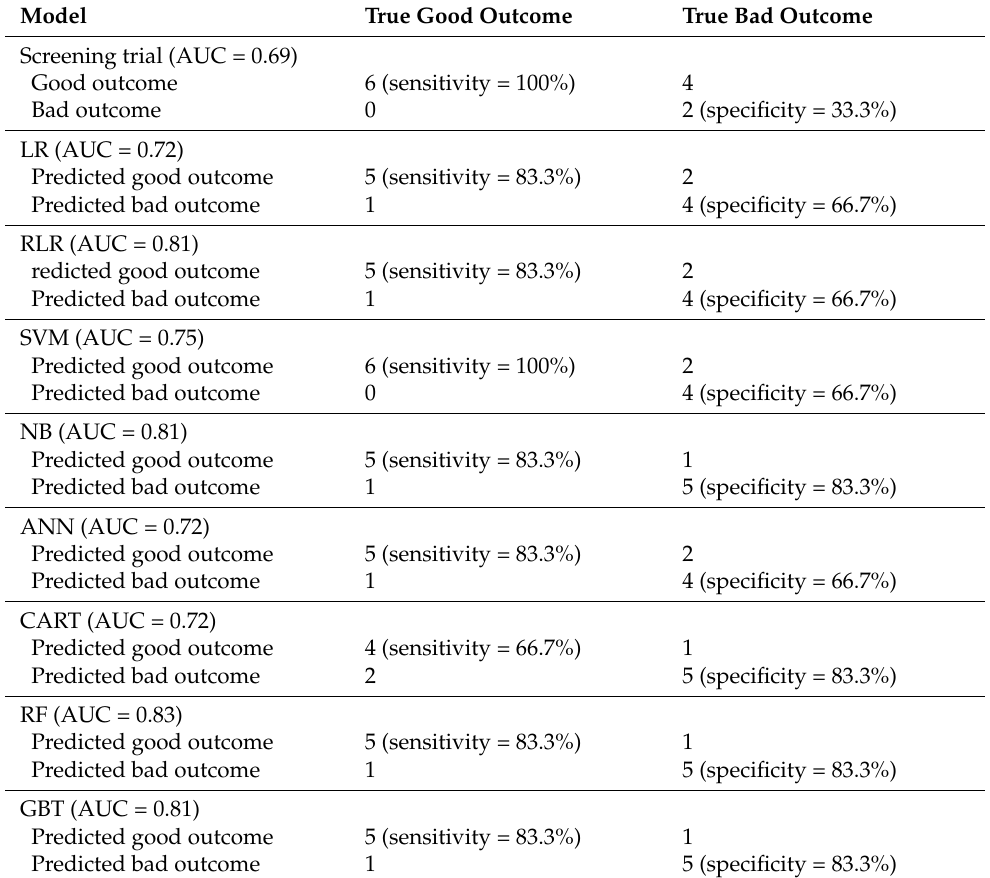
Table 4. AUC, specificity and sensitivity of screening trial and our model on the external validation set. Model True Good Outcome True Bad Outcome Screening trial (AUC =